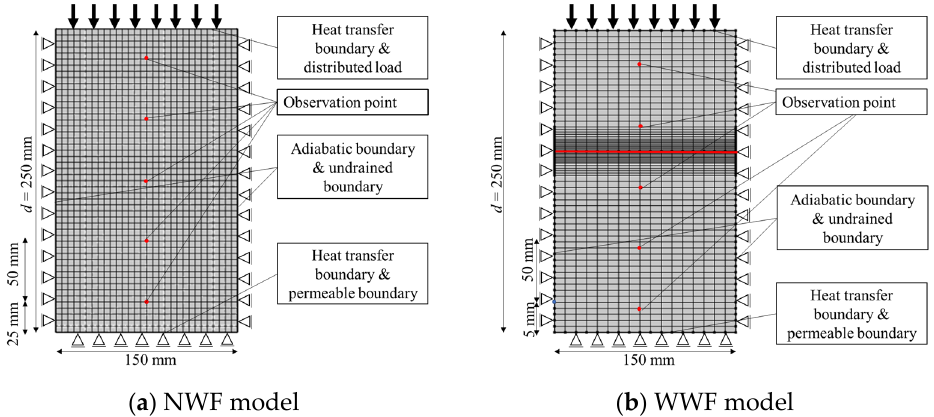
Figure 5. Numerical model and boundary conditions for frost heave